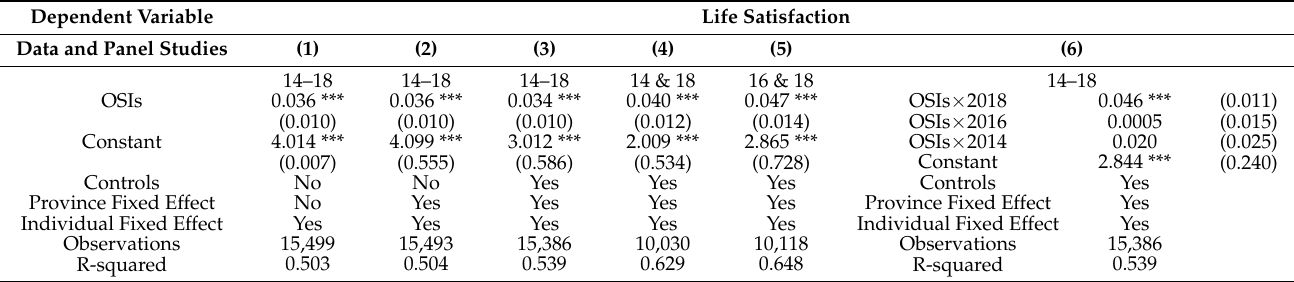
Table 2. The effects of OSIs on the LS of older Chinese